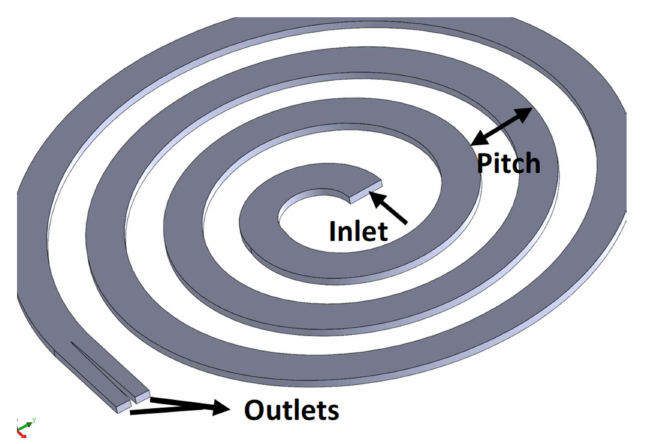
Figure 3. Schematic of the fluidic system used for optimization.